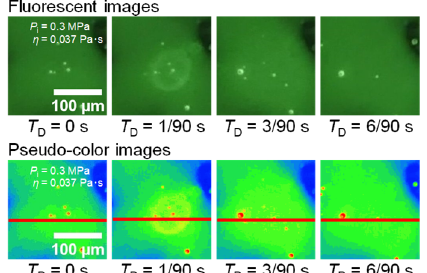
Figure 7. Fluorescent and pseudo-color images of the paint droplet.